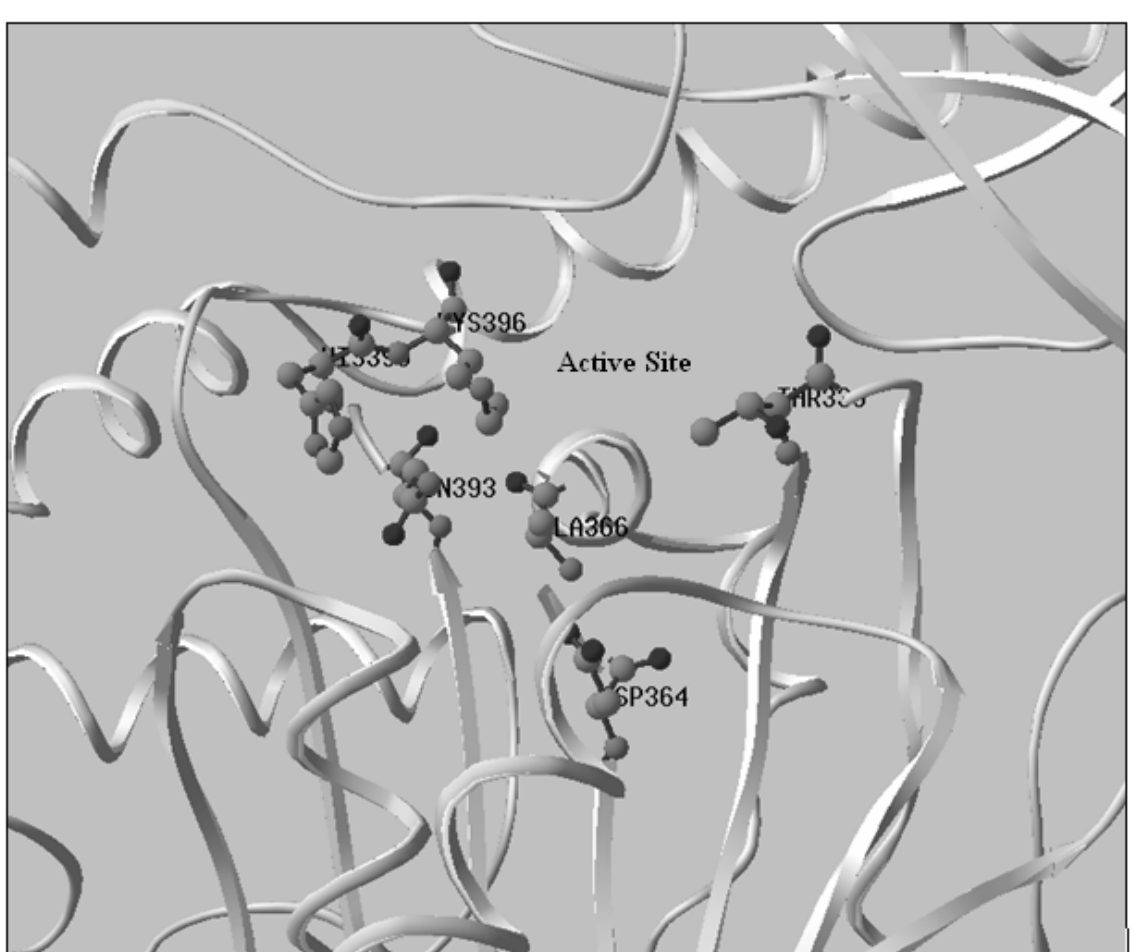
Figure 9: Active site of GAD65. Starting from the residues of the active site of the DOPA molecule (Fig. 8), the corresponding residues of the GAD65 molecule are determined from the alignment (Fig. 4). The residues are labelled by name and number and represented as